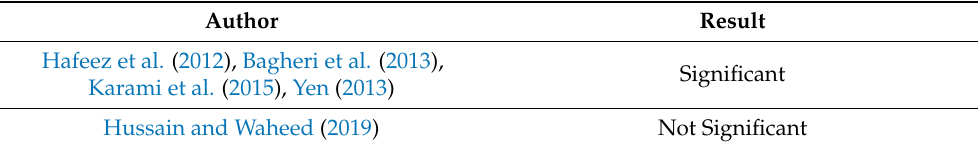
Table 1. The results from previous studies that studied the relationship between company resources and business performance were